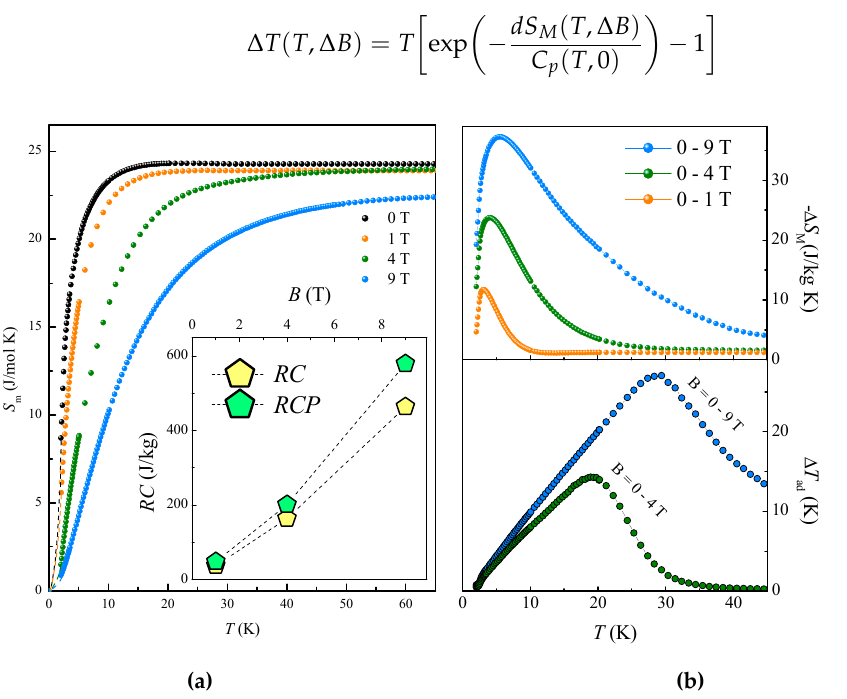
Figure 5. The temperature dependence of the magnetic entropy S M in various magnetic fields. The inset shows the field dependences of the refrigerant capacity RC and the relative cooling power RCP ( a ). The magnetic entropy Δ S M and adiabatic temperature change Δ T ad ( b ).